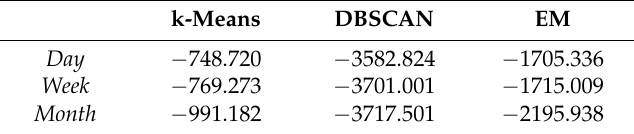
Table 1. Cluster Density evaluation results upon the selected clustering algorithms.